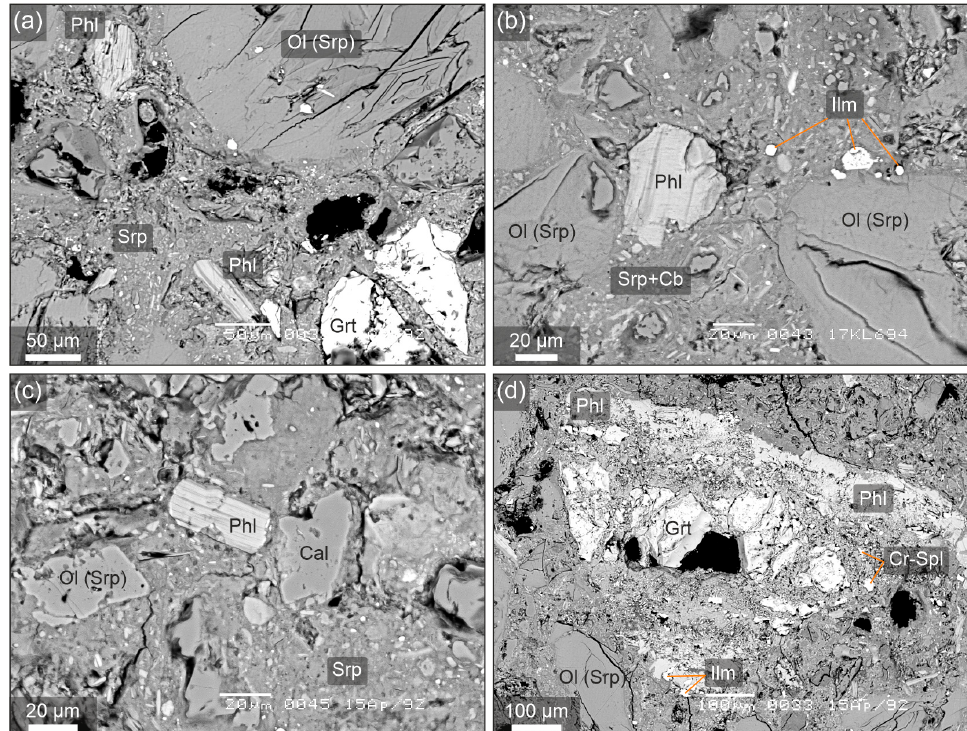
Figure 3. Back-scattered electron (BSE) images of volcanoclastic kimberlite breccias from pipe 688 (sample AP-92): ( a ) kimberlite matrix consists of serpentine, phlogopite, oxides with fragments of garnet xenocrysts and serpentinized olivine macrocrysts; ( b , c ) rare phlogopite grains set in the carbonate–phlogopite kimberlite matrix; ( d ) the fragment of garnet xenocryst partly altered to